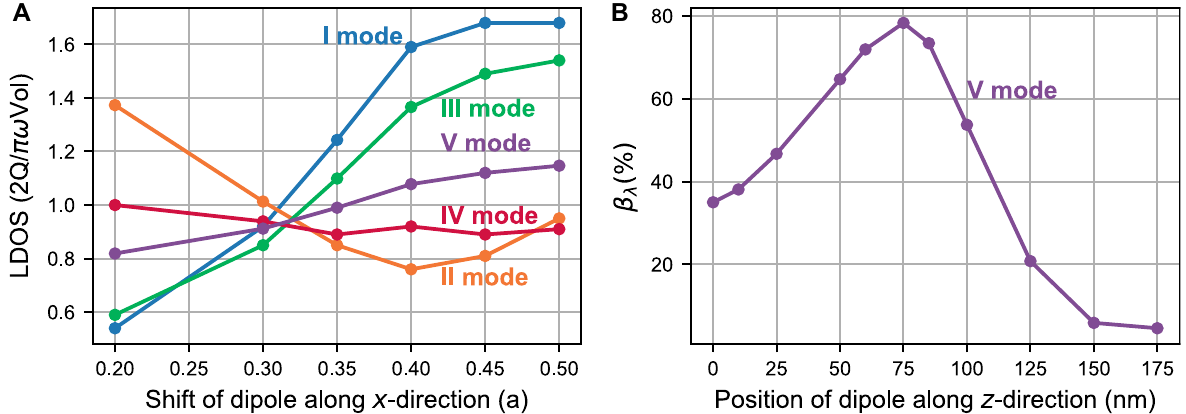
Figure 2: Simulation of ND position on cavity interaction zone. A Simulated LDOS enhancement for different resonance modes of the emitted light from the dipoleembeddedin a 200 nm cube-shaped ND, dependenton its longitudinal position weighted by the cavity periodicity a . The position of the ND is chosen according to its experimental position in Figure 1C, while the dipole position is varied along the x -direction. B Simulated on-resonance coupling ef fi ciency β λ into researched V-order resonance mode, dependent on the position of the dipole along the z -axis(keeping y and x position fi xed atitsoptimum).The highestcouplingef fi ciencyisachievedfora displacement of 60nm abovethecavity